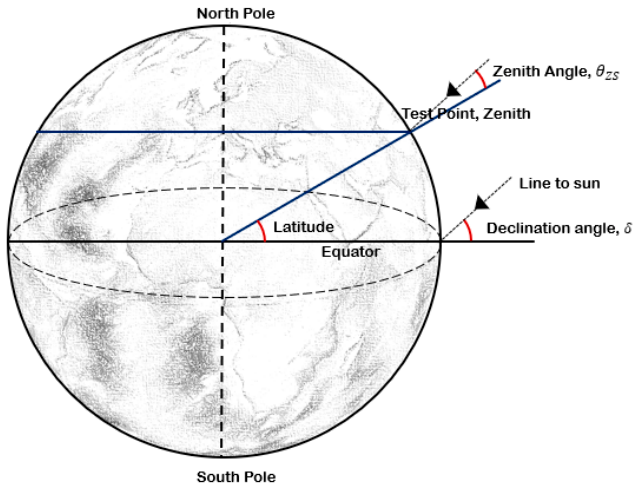
Figure 4. Terminologies for the measurement.